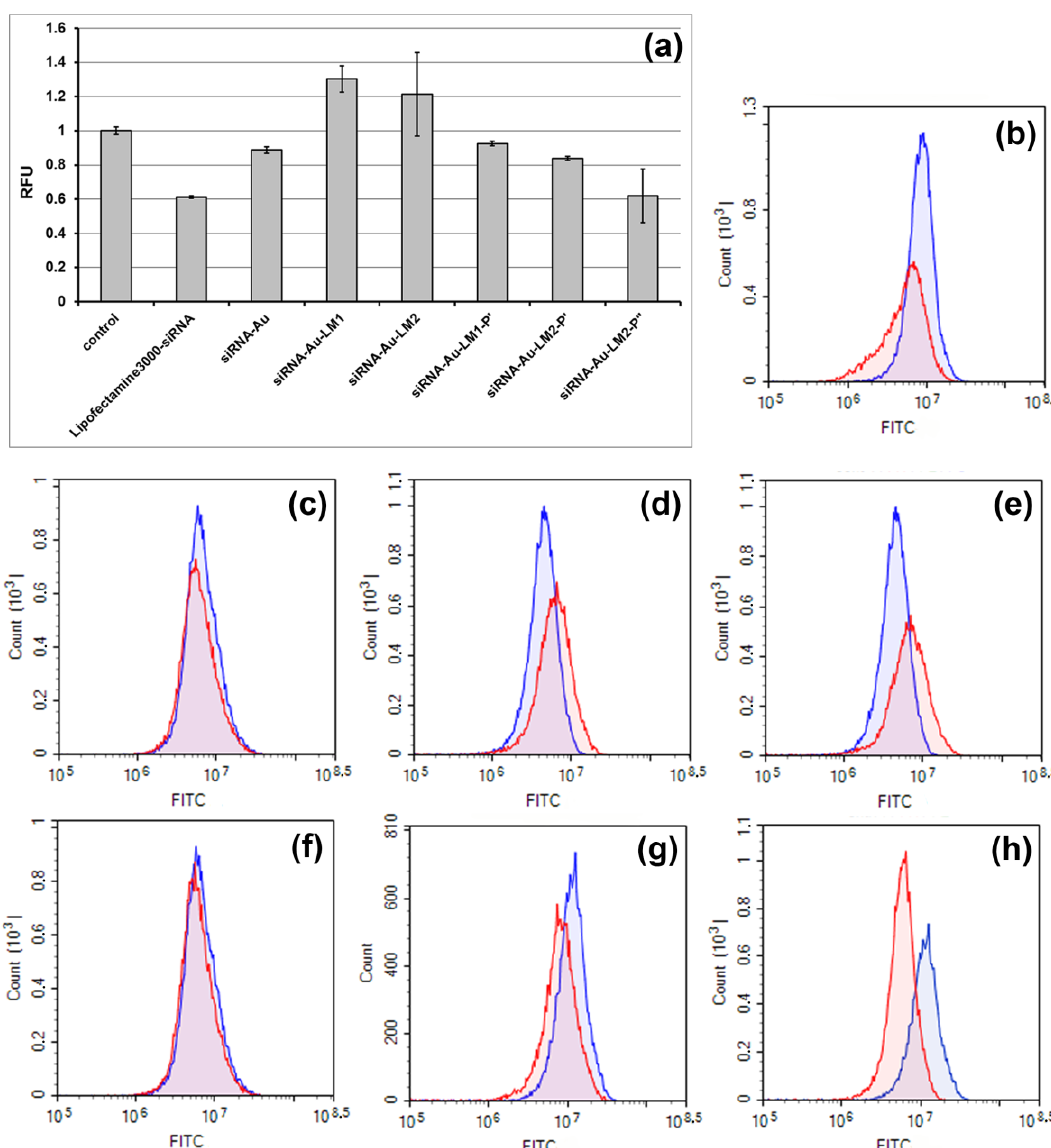
Figure 11. Silencing of GFP gene expression in HEK-Phoenix cells possessing stably expressed GFP by siRNA delivered with different vehicles. ( a ) The normalized mean value of the cell fluorescence (RFU = RFUexp/RFU control) after transfection with: Lipofectamine 3000 complex with siRNA (Lipofectamine3000/siRNA); cores siRNA-Au; particles siRNA-Au-LM1; siRNA-Au-LM2; siRNA-Au-LM1-P’; siRNA-Au-LM2-P’; and siRNA-Au-LM2-P”. Example of flow cytometry analysis, cells were incubated with: Lipofectamine 3000 complex with siRNA ( b ); cores siRNA-Au ( c ); particles siRNA-Au-LM1 ( d ); siRNA-Au-LM2 ( e ); siRNA-Au-LM1-P’ ( f ); siRNA-Au-LM2-P’ ( g ); and siRNA-Au-LM2-P” ( h ). In blue, signal corresponding to fluorescence of non-transfected cells. More than ten thousand events were counted in each sample; mean values from three independent experiments are presented.